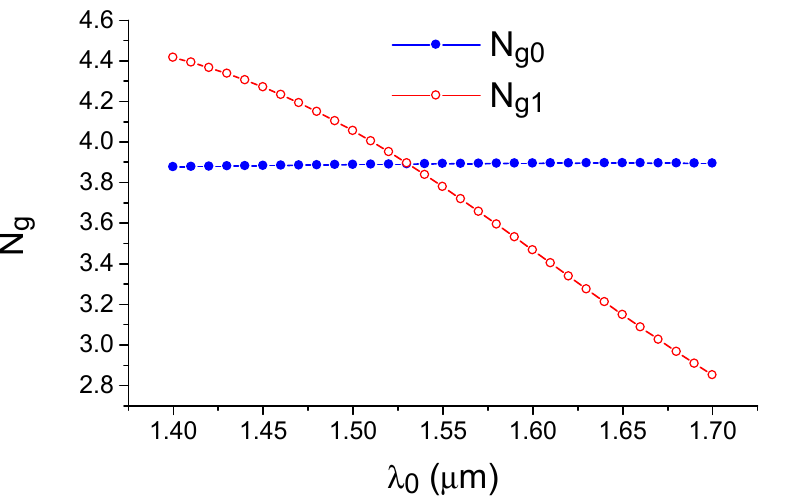
Figure 2. Group index dependence of the fundamental TE 0 and first modes TE 1 of a silicon waveguide on the optical wavelength. The curves intersection (PMTP) is observed in the telecommunication range (1550 nm). Calculation by the effective index method.